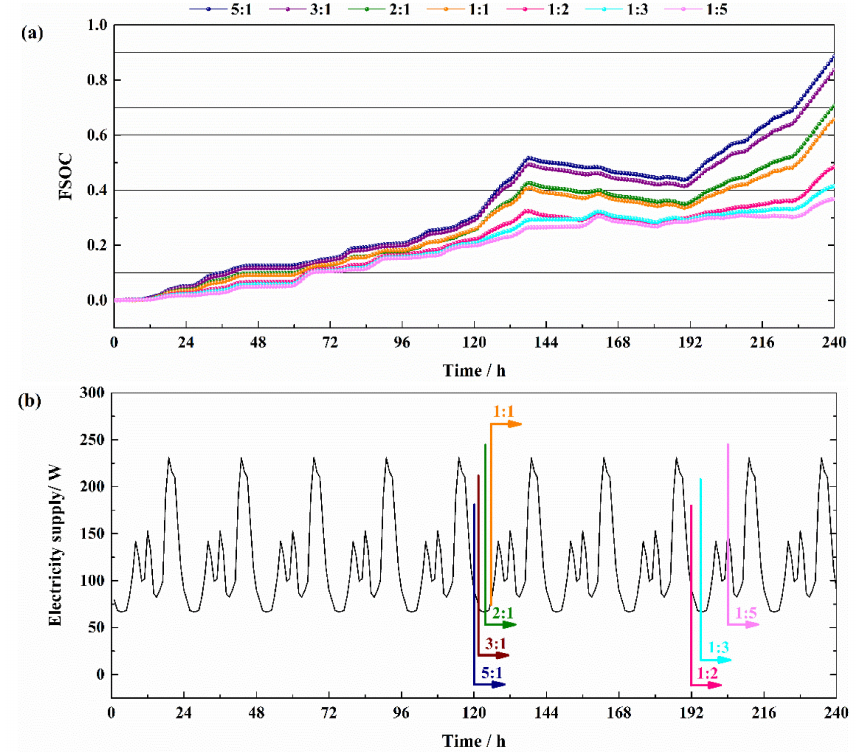
Figure 10. Power supply guarantee rate with different installed capacity ratios of WT and PV in Kaba-He.